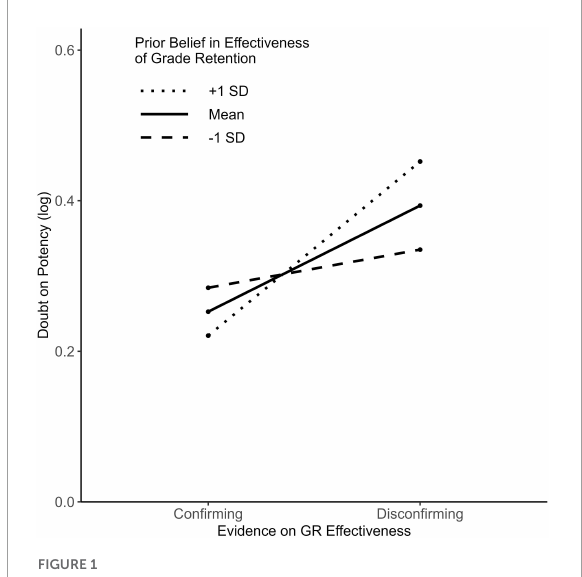
FIGURE1 Doubt on the potency of science to study the effectiveness of grade